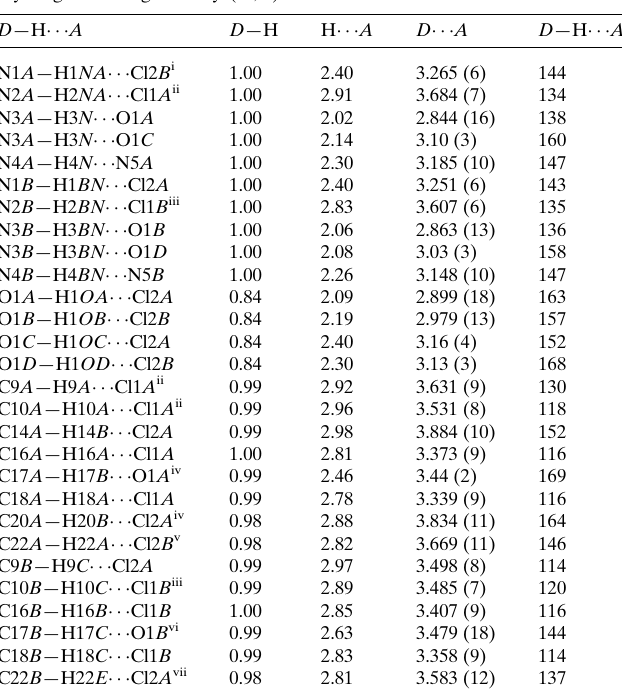
and N—H (cid:2) (cid:2) (cid:2) Cl hydrogen bonds to both the interstitial chloride anions as well as the cobalt-bound chlorine. The chloride anions are also acceptors for O—H (cid:2) (cid:2) (cid:2) Cl hydrogen bonds originating from the disordered methanol molecules